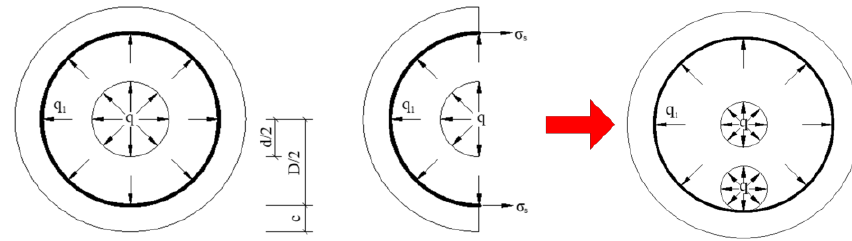
Figure 14. Stress distributed on the cross section.